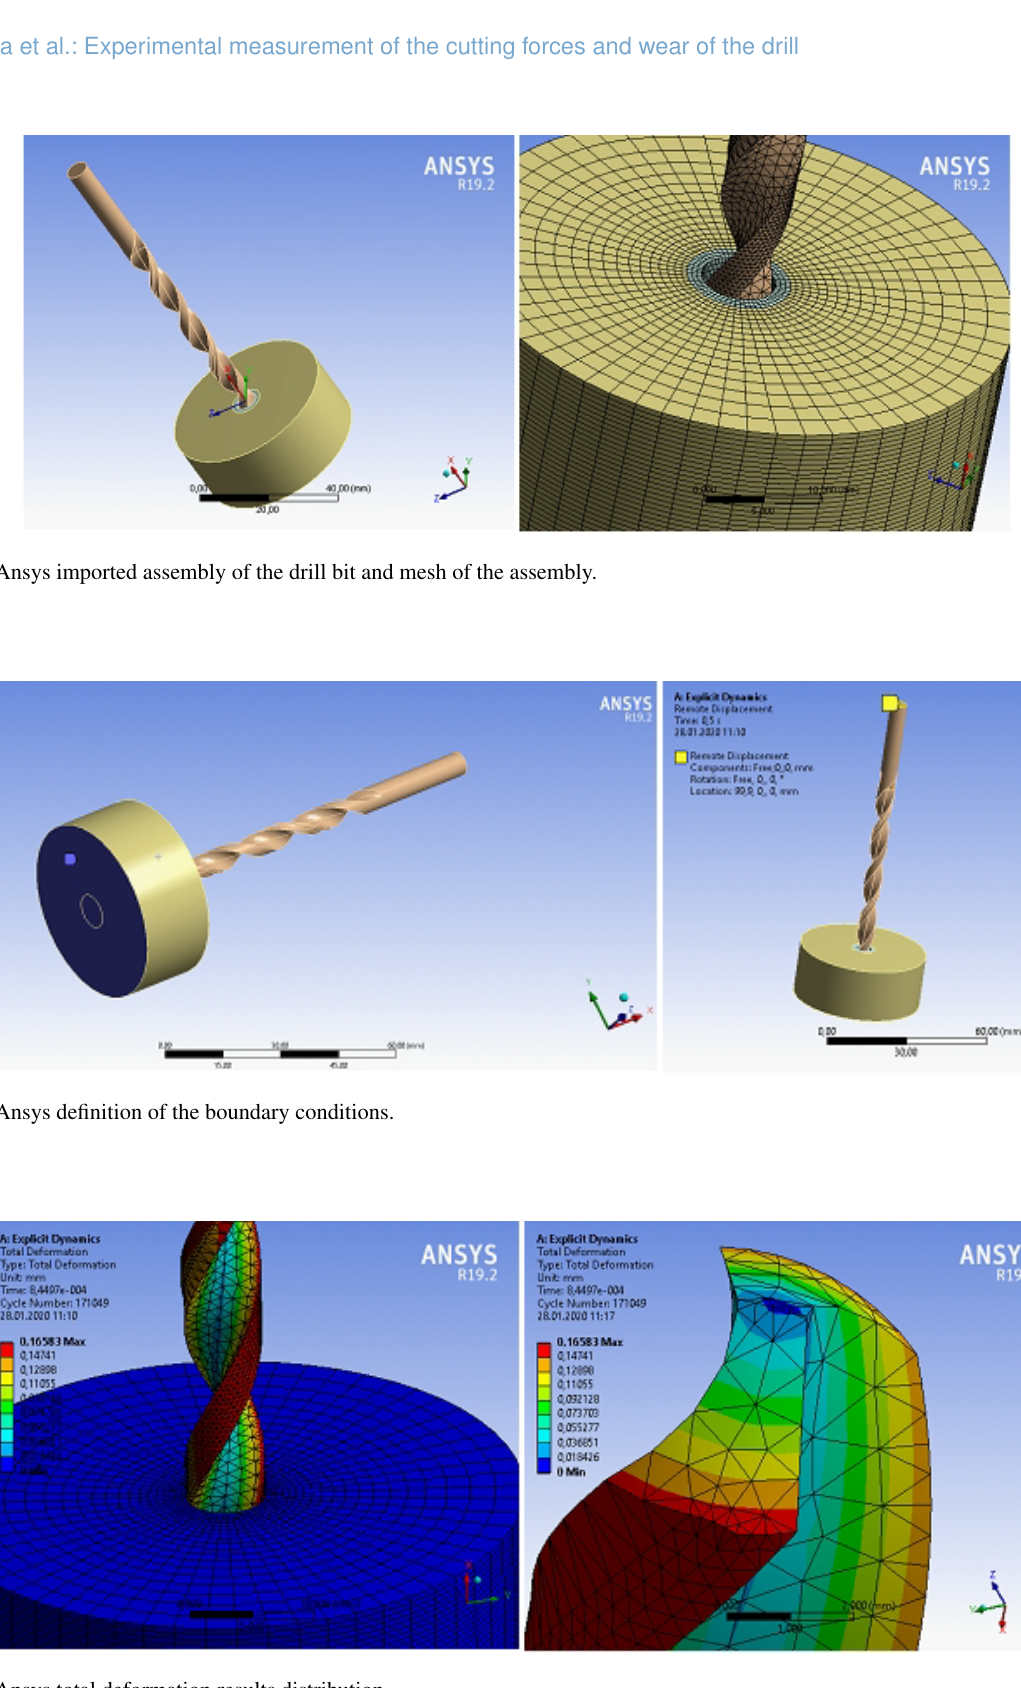
Figure 32. Ansys total deformation results